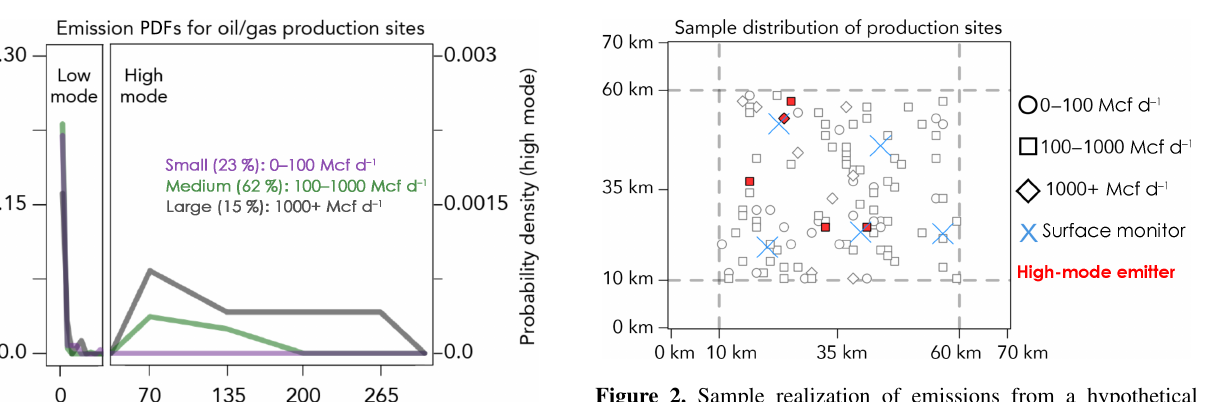
Figure 2. Sample realization of emissions from a hypothetical oil/gas production field with 100 production sites of different pro- duction size categories (symbols) within a 50 × 50km 2 domain (dashed line). Different production size categories are shown with symbols. Red shading indicates high-mode emitters. Blue symbols mark the locations of five surface air monitoring sites placed ac- cording to the k -means